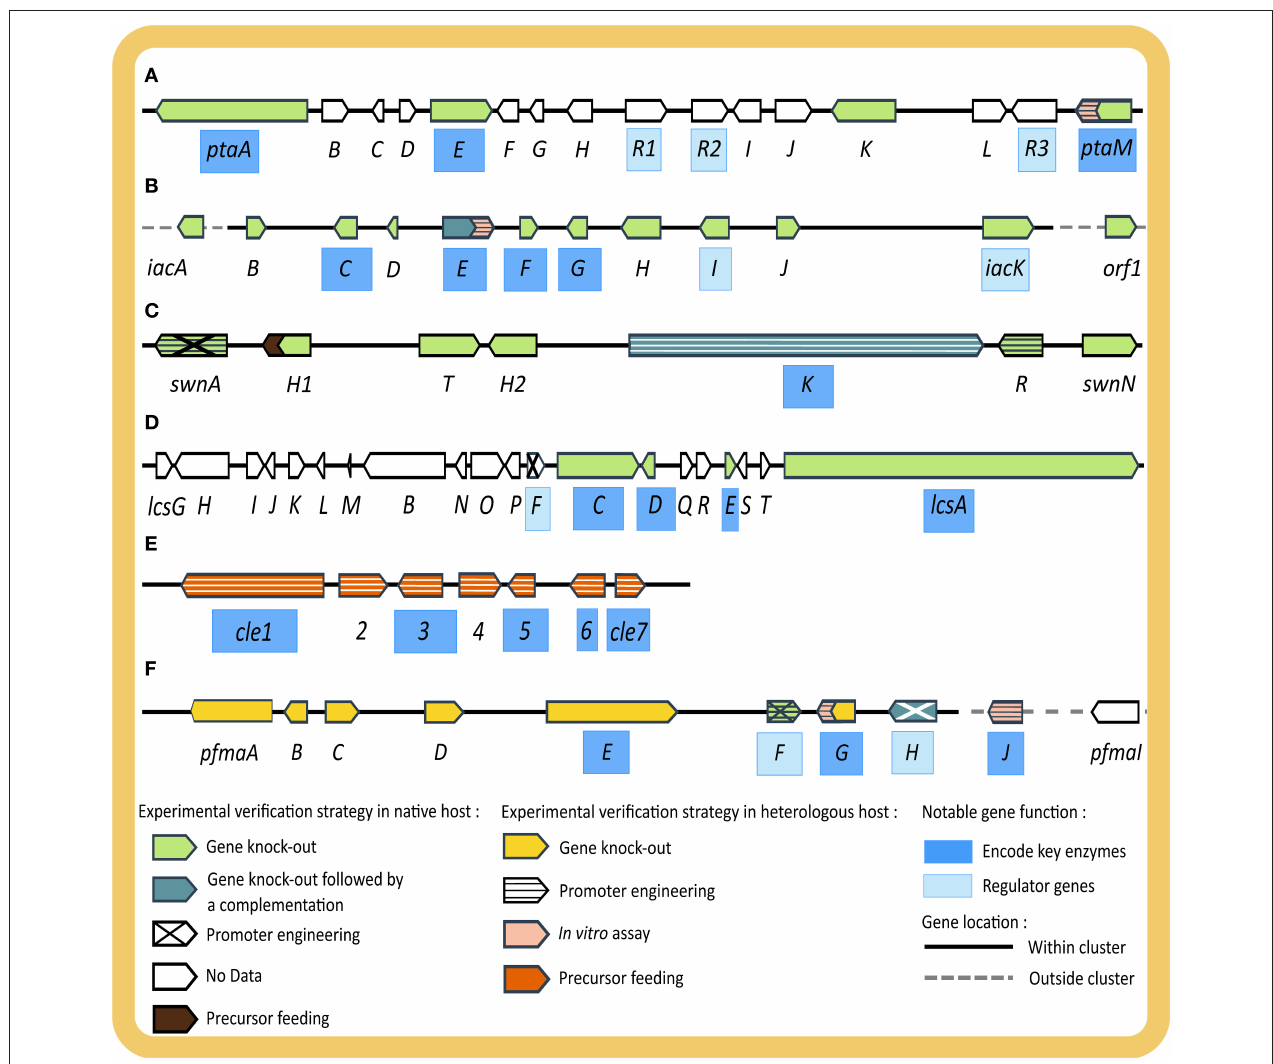
FIGURE 3 | Illustration of four BGCs discovered in studies starting from phenotypic observation (A–D) and two BGCs from genotypic observation (E,F) including the experimental strategies used to verify and characterize their functions. (A) pta giving rise to pestheic acid ( 20 ), (B) iac encoding enzymes for isoA82775C ( 21 ), (C) SWN shown to be essential for swainsonine ( 2 ) production, (D) lcs giving rise to leucinostatin ( 13 ), (E) cle involved in the biosynthesis of chevalone E ( 18a ) and its derivatives ( 18b, 18c ), and (F) pfma essential for the production of 1,8 DHN ( 25 ) melanin. Genes are indicated as arrowheads, with names of genes encoding key enzymes highlighted in dark blue, (putative) regulatory genes in light blue. Fill and pattern of arrowheads depict experimental evidence (native host: light green—gene knock-out, dark green—gene knock-out followed by rescue via gene complementation, diagonal cross—promoter engineering, no pattern with white fill—no experimental data, brown—precursor feeding experiment; heterologous host: yellow—gene knock-out, horizontal stripe—promoter engineering, pink— in vitro assay, orange—precursor feeding experiment). Genes located within BGC are connected with a solid black line while genes outside the BGC with dotted gray